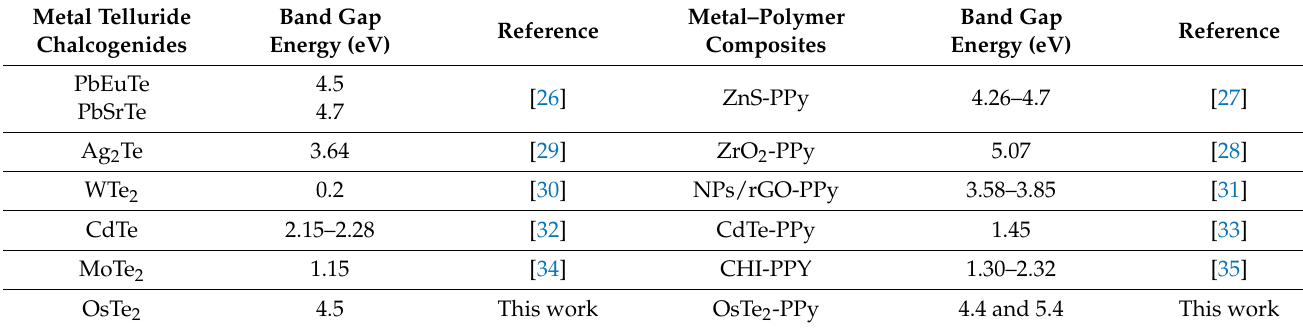
Table 1. Energy band gap values of metal telluride chalcogenides and metal–polymer composites.